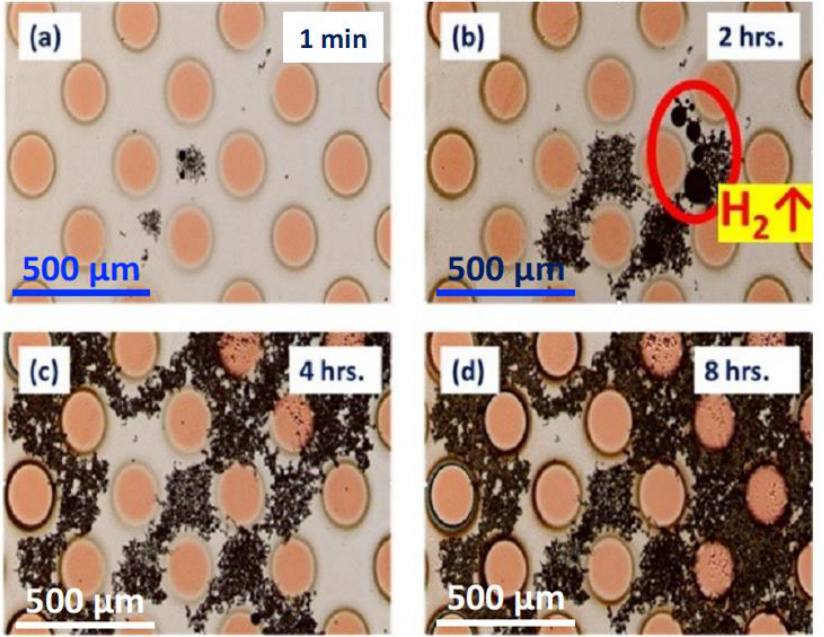
Figure 6. Micropattern corrosion screening of Al/Cu bimetallic contact immersed in 5 ppm Cl − solution at pH 5. The images were taken ( a ) soon after immersion ( b ); immersion time = 2 h, ( c ) 4 h, ( d ) 8 h.